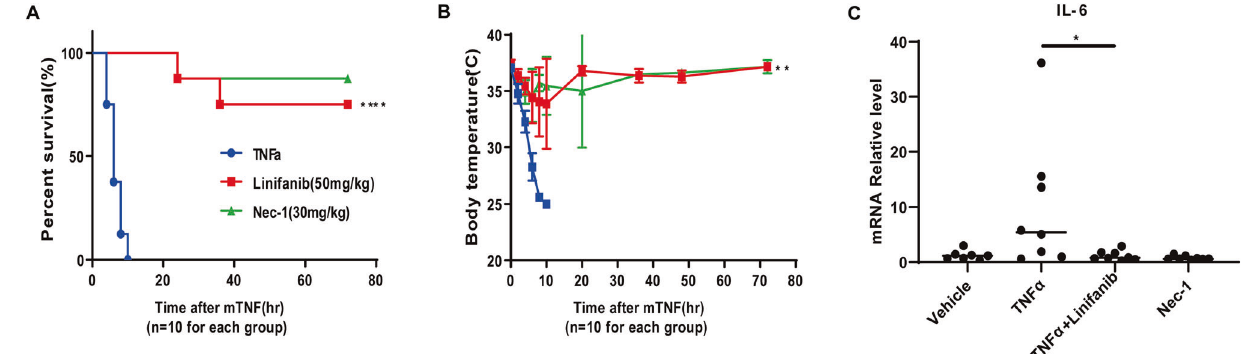
Fig. 6 Linifanib protects mice against SIRS induced by TNF- α . Ten-week-old male C57BL/6 J mice were pretreated with or without linifanib (50 mg·kg-1 gavage) or Nec-1 (30 mg·kg-1 gavage) for 30 min, and then SIRS was induced with mTNF α (5 μ g/ mice i.v.). Control mice received an equal amount of vehicle before mTNF- α challenge. A The survival curve and B the mouse body temperatures (means ± SEM) of linifanib- treated mice ( n = 10 for each group), Nec-1-treated mice ( n = 10 for each group), and vehicle control mice ( n = 10 per group) are shown. The results are presented as the mean value ±S.D. ** p < 0.01, **** p < 0.0001. C After SIRS induction for 6 h, the IL-6 levels of lung tissues were determined by real-time PCR. Results represent the mean±S.D. from six mice. ** p < 0.01, signi fi cantly different from vehicle control quanti fi cation of multilevel cell responses before and after treatment [47]. The LINCS L1000 library exploits correlations between gene expression; using small molecules to treat human cell lines, they identi fi ed 978 genes as genome-wide markers in 384-well plates based on large-scale statistical analysis. The expression of other genes can then be calculated by measuring the expression of marker genes. Changes in the nearly 1000 genes adopted by L1000 represent approximately 80% of gene change information in humans [48]. Drug perturbation genesets in LINCS can be divided into three groups: (1) landmark space, containing 978 landmark genes based on probe fl uorescence intensity data measured experimentally, scaled, and standardized after calculation with the control group; (2) all inferred genes, containing 978 landmark genes and 11,350 genes whose expression data are inferred, totaling 12,328 genes; and (3) best inferred genes, which contain 978 landmark genes and 9196 high- fi delity inferred genes from 11,350 inferred genes, totaling 10174 genes used in drug prediction. To identify potential therapeutic drugs for sepsis, we obtained the gene expression pro fi les perturbed by small molecule compounds from the LINCS L1000 level 5 dataset. The perturbation data of each small molecule compound included the gene expression data of different cell lines after different doses and treatment times. Kolmogorov – Smirnov test . The Kolmogorov – Smirnov test (KS test) is a nonparametric test based on a cumulative distribution function to test whether an empirical distribution conforms to a theoretical distribution or to compare whether there is a signi fi cant difference between two empirical distributions [49, 50]. X 1 , X 2 , … , X m , Y 1 , Y 2 , … , Y n are two independent random samples, and the distribution functions are F